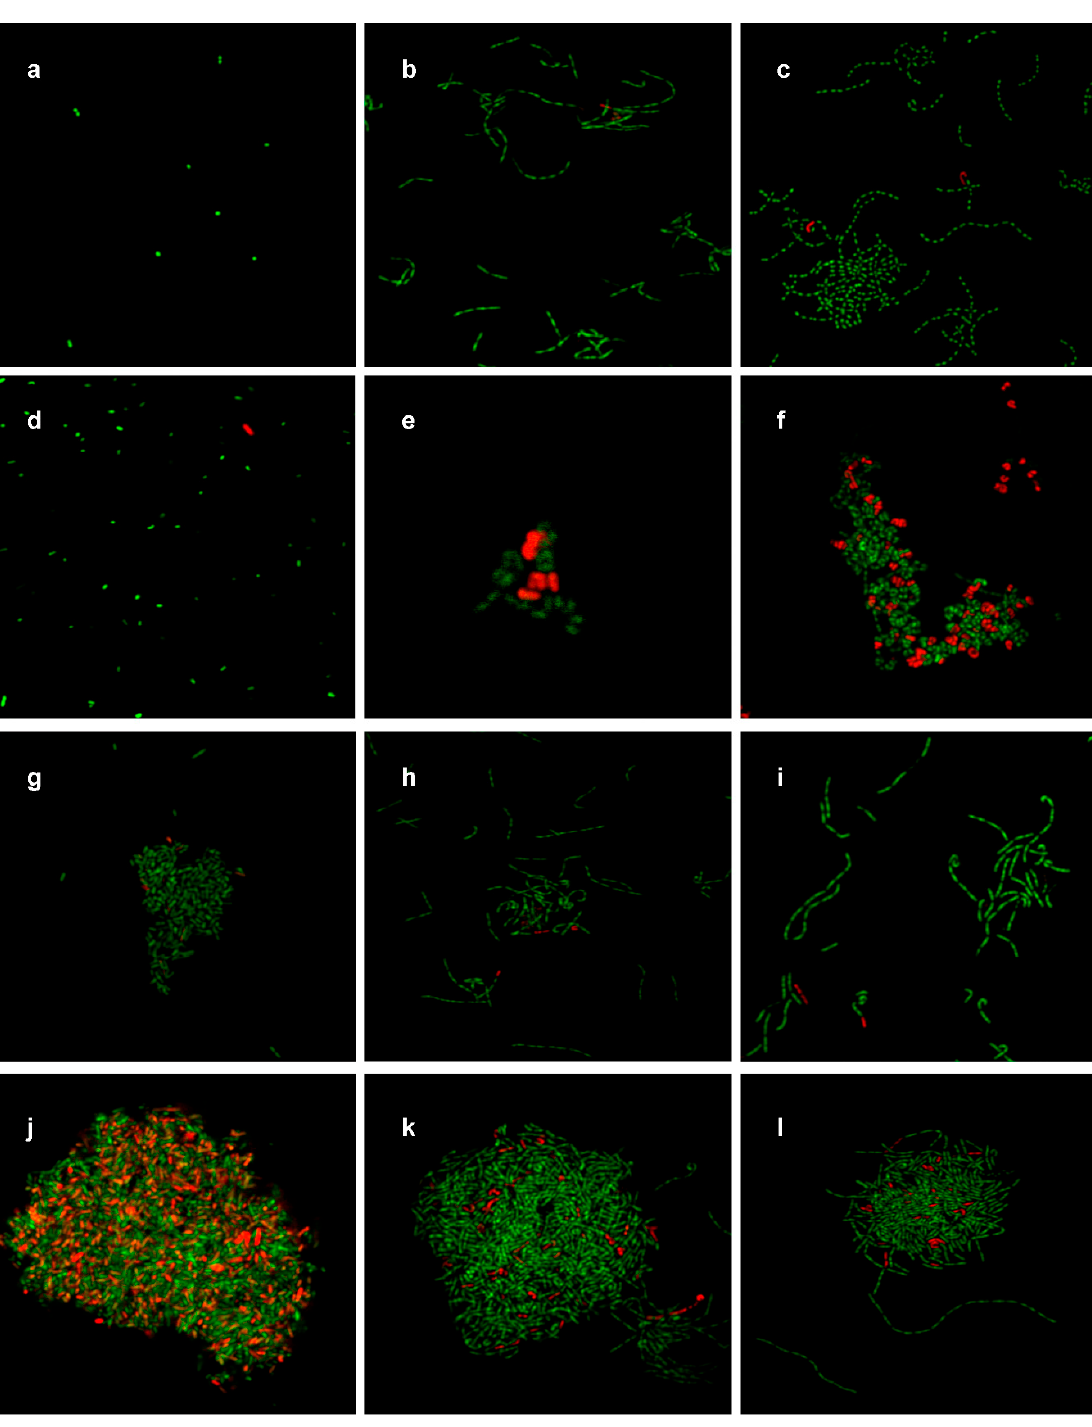
Figure 11. Bac Light™ fluorescence microscopic images of untreated E. coli ( a , g ), L. acidophilus ( b , h ) and B. animalis ( c , i ); 20 mM ZnO NP-treated E. coli ( d ), L. acidophilus ( e ) and B. animalis ( f ); and 4.6 mM Ag NP-treated E. coli ( j ), L. acidophilus ( k ) and B. animalis ( l ). Green indicates live cells while red indicates dead cells.